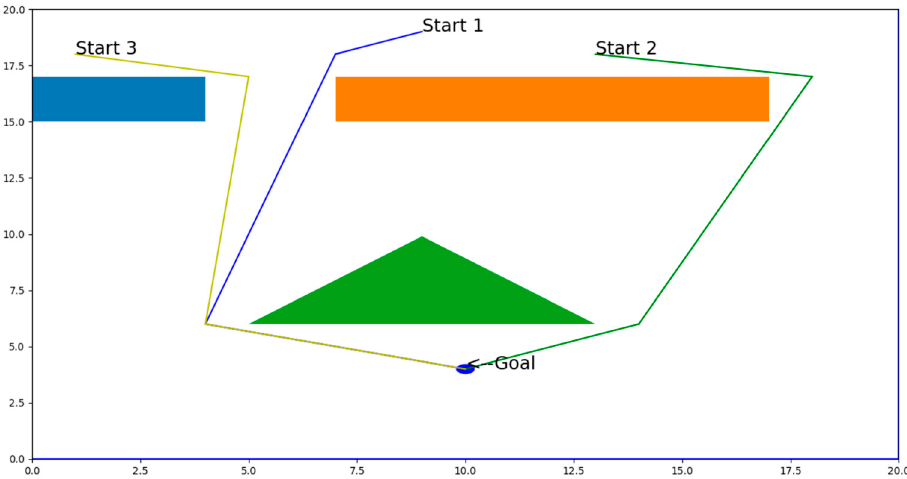
Figure 13. Sample trajectories for data collection in another scenario.